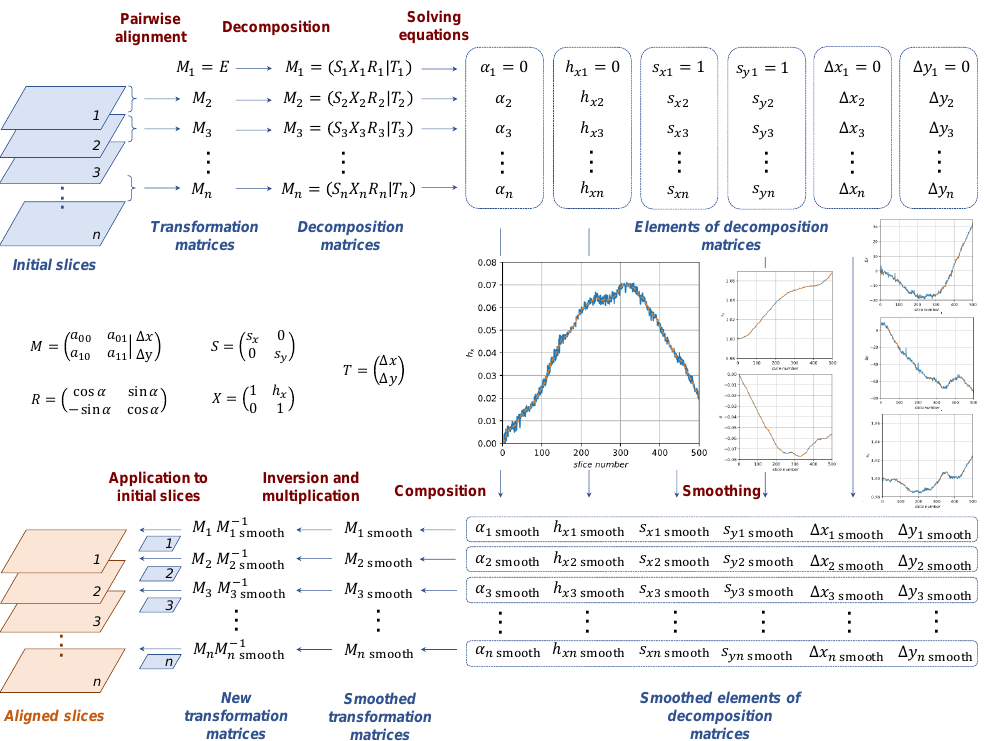
Figure 9. Initial and smoothed elements of decomposition for sample A: ( a ) displacement along the X axis, ∆𝑥 ; ( b ) displacement along the Y axis, ∆𝑦 .